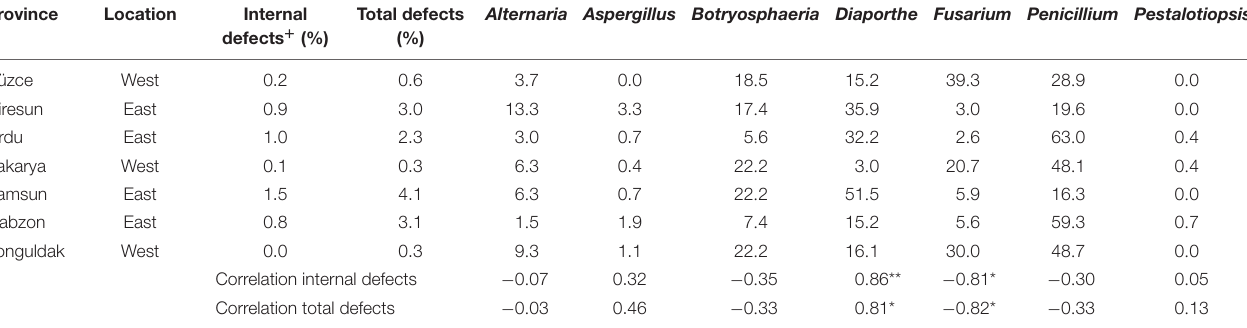
TABLE 5 | Pearson correlation analysis, run between incidence of hazelnuts defects (internal and total) and incidence of fungi at full ripening. Province Location Internal defects + (%)